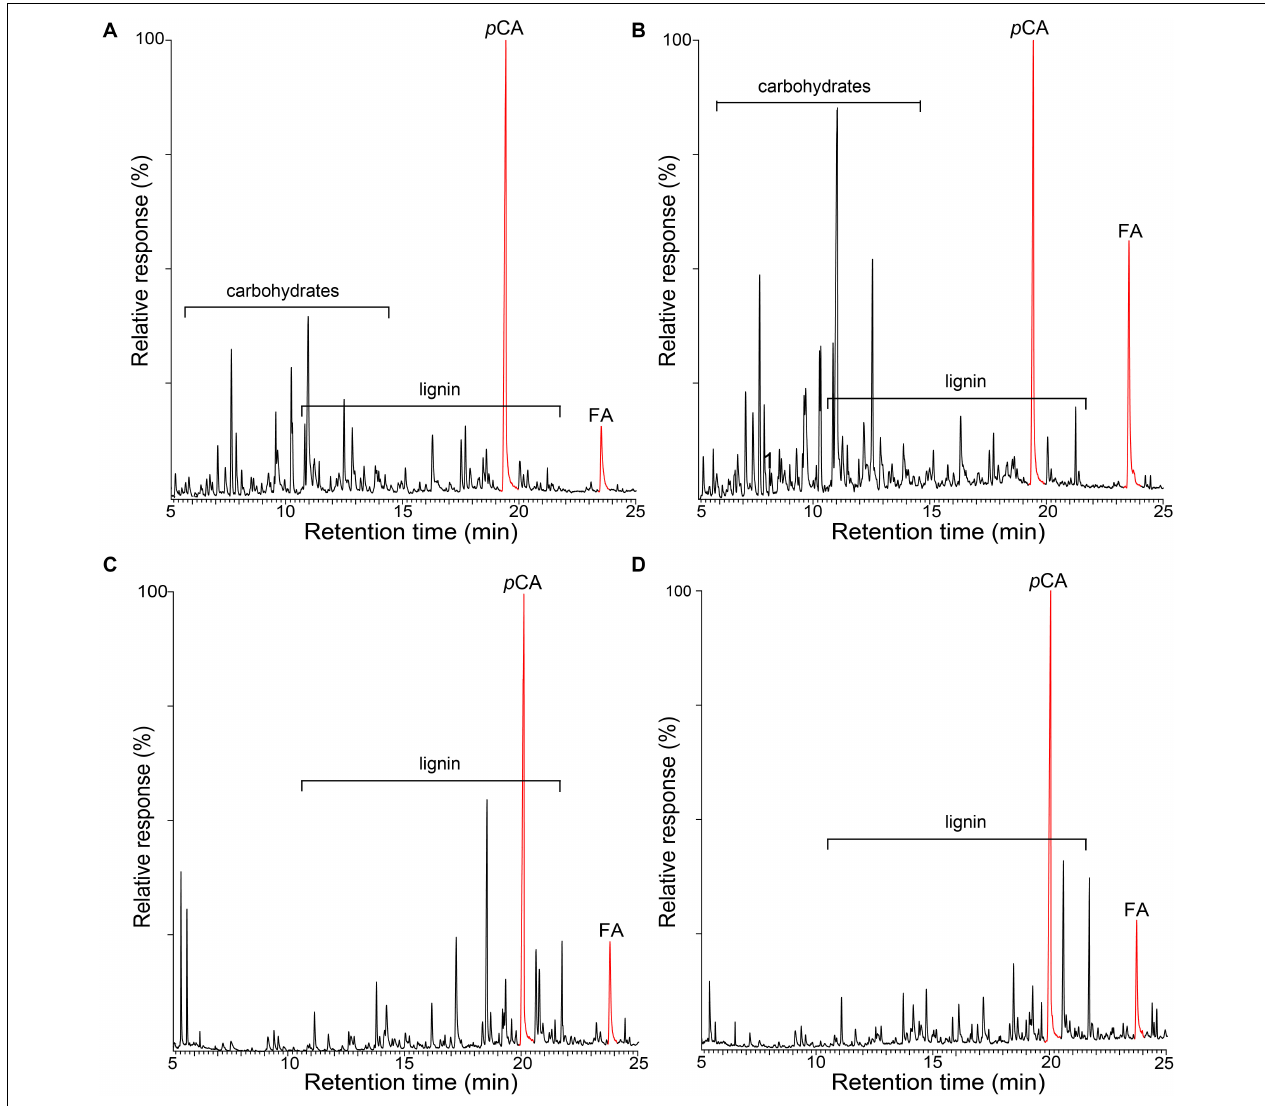
FIGURE 2 | Py-TMAH-GC/MS chromatograms of the whole cell walls of rice husks (A) and rice straw (B) , and of the isolated MWLs from rice husks (C) and rice straw (D) . p CA is the fully methylated p -coumaric acid (methyl trans -4- O -methyl- p -coumarate); FA is the fully methylated ferulic acid (methyl trans -4- O